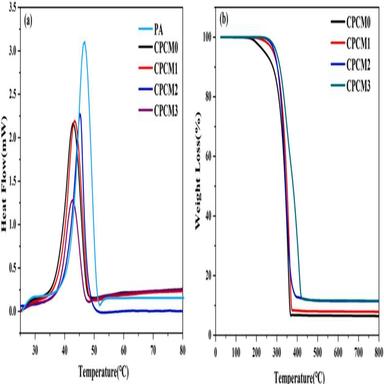
DSC and TGA curves of different materials: (a) DSC; (b) TGA.